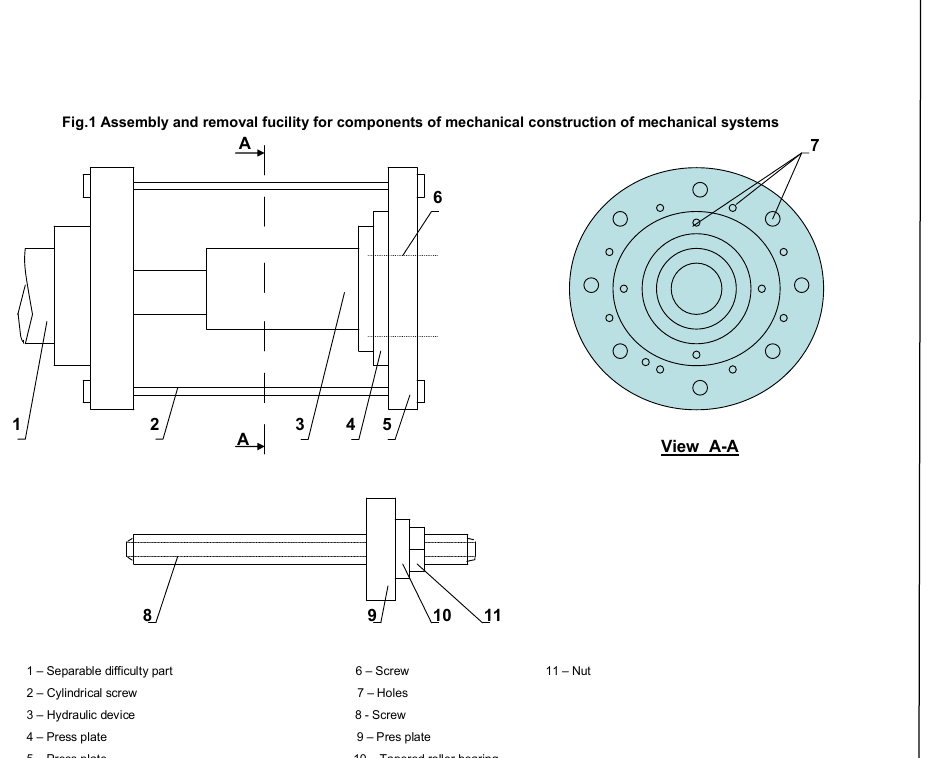
Slika 9 – Ure đ aj za demontažu i montažu teško rastavljivih sklopova na mašinskim postrojenjima Рис . 9 – Установка для монтажа и демонтажа сложных узлов на механизации Figure 9 – Device for mounting and demounting not easily separable assemblies on mechanical